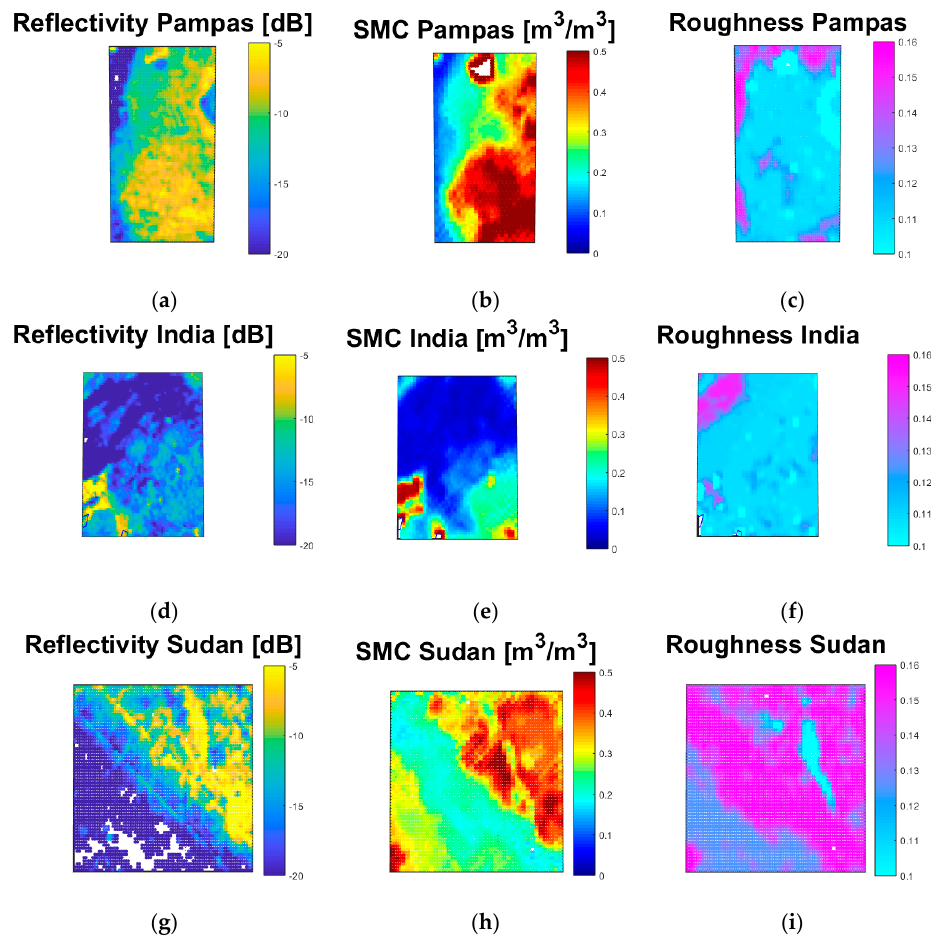
Figure 8. Close-up study over Argentinian Pampas ( a – c ) , India ( d – f ), and Sudan ( g – i ). CyGNSS reflectivity Γ LHCP,CyGNSS ( a , d , g ), soil moisture content (SMC) ( b , e , h ), and surface roughness parameter h ( c , f , i ) are displayed